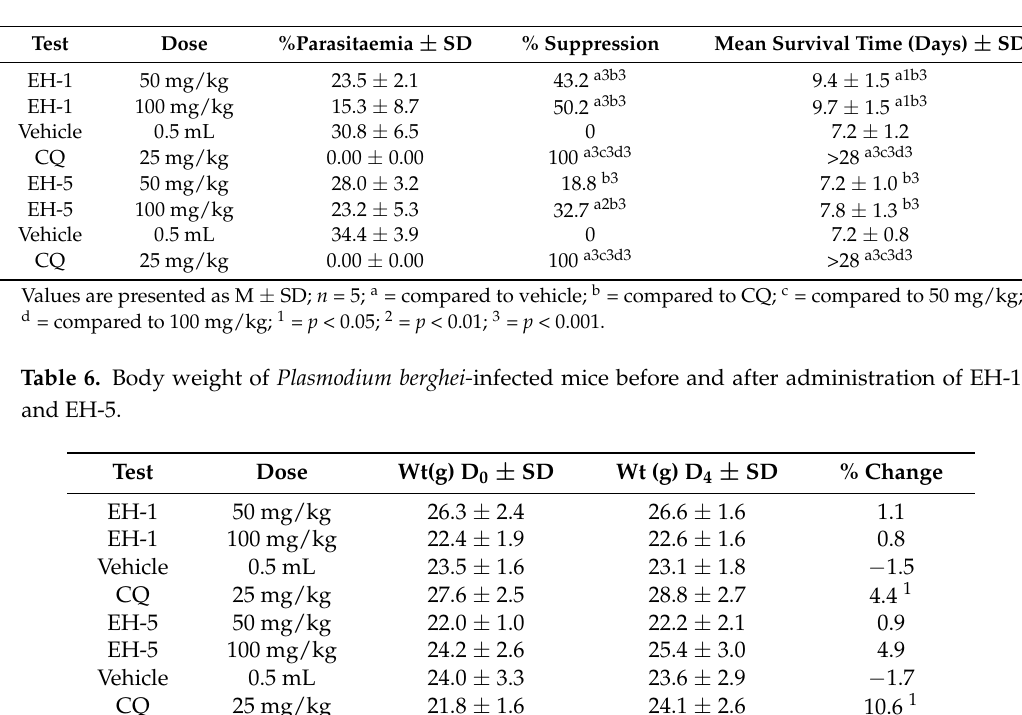
Table 5. Percentage suppression and mean survival time of Plasmodium berghei- infected mice after administration of EH-1 and EH-5.